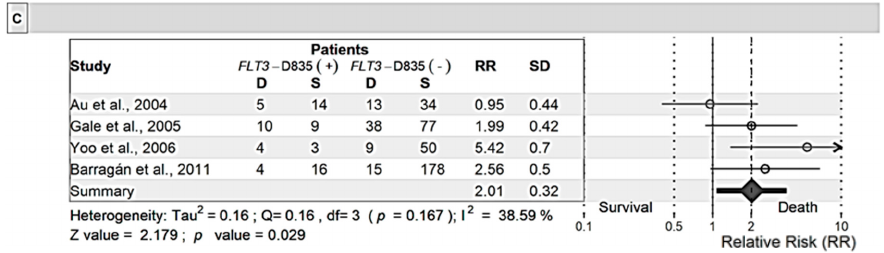
Figure 5. Meta-analysis of the relative risk for patients with the FLT3 -D835 mutation. Induction death ( A ), complete remission ( B ), and overall survival ( C ). Mixed effects models were used for analysis. D: